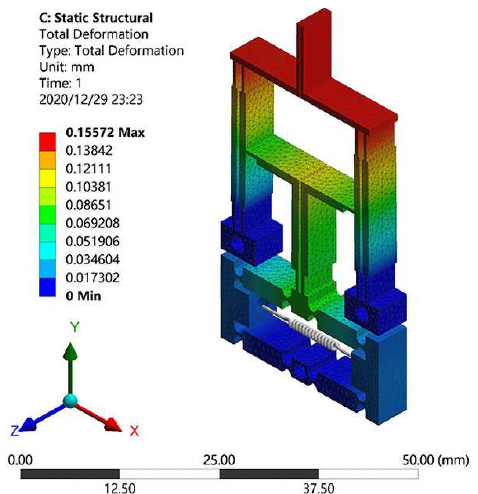
Figure 6. Simulation result of total deformation for the microgripper.